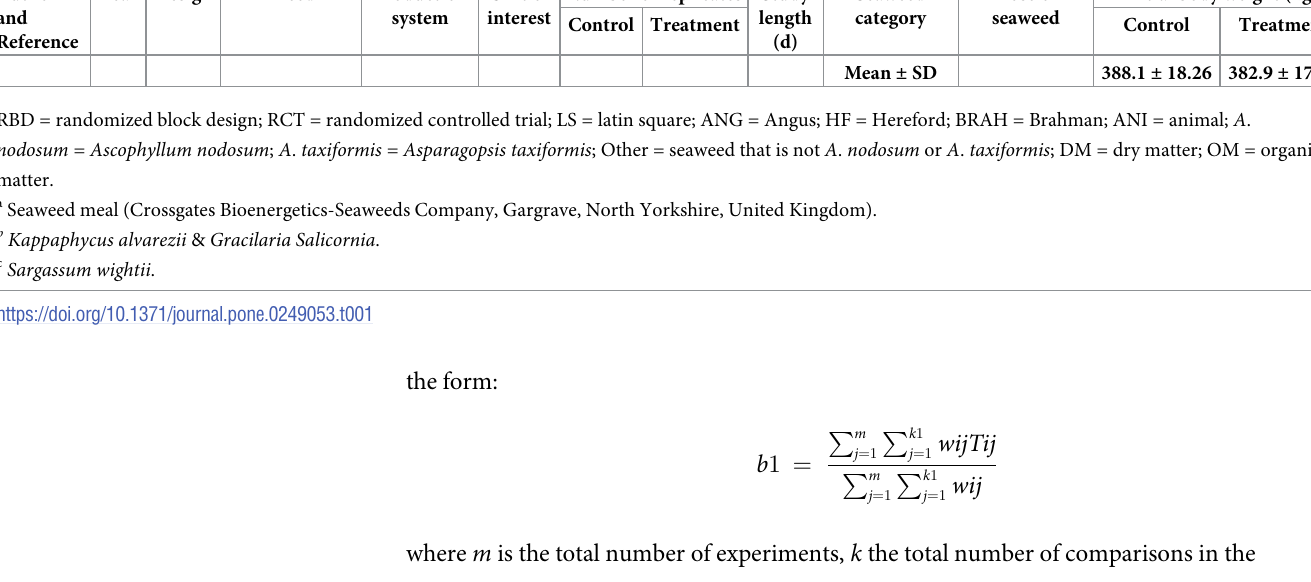
Table 2. Mean ± SD of control and treatment group production outcomes for each comparison included in analysis. Author and reference Year Seaweed